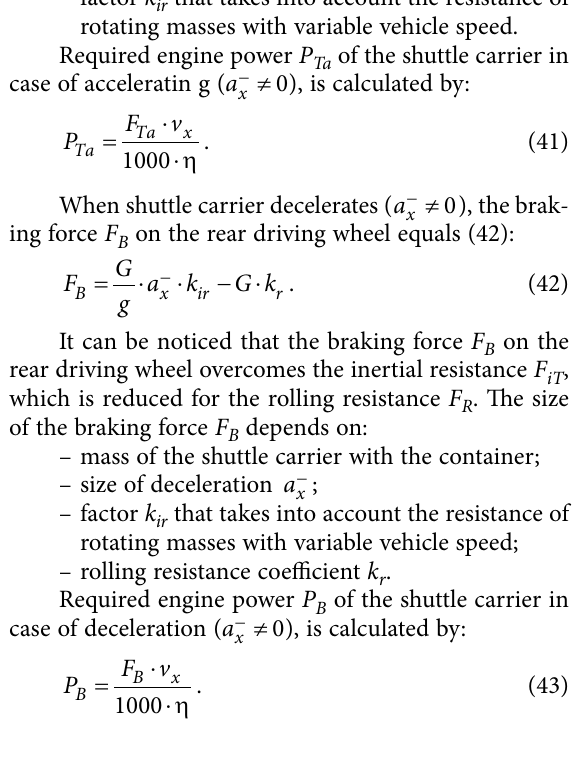
table in the case of hoisting with non-constant